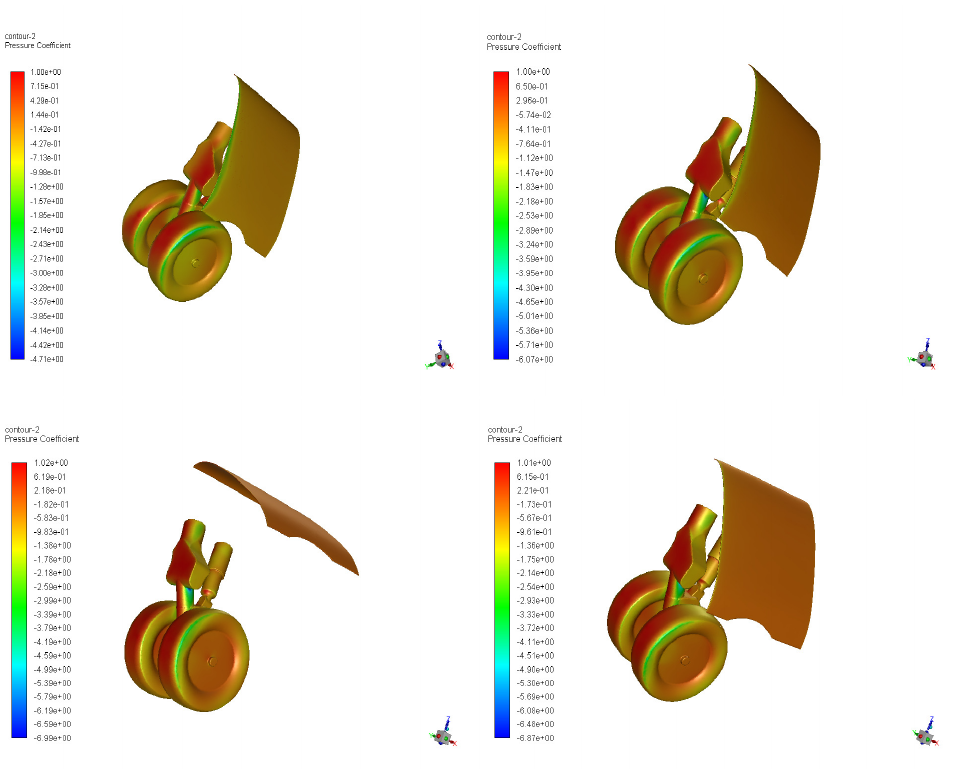
Figure 15. MLG: pressure distribution during the lowering phase (clockwise), for the case MLG-I.